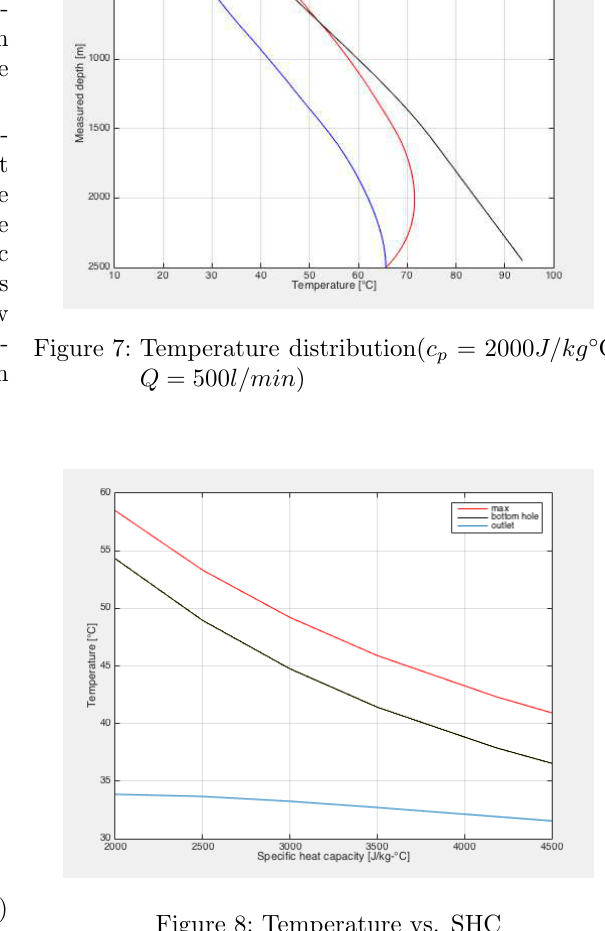
Figure 8: Temperature vs.